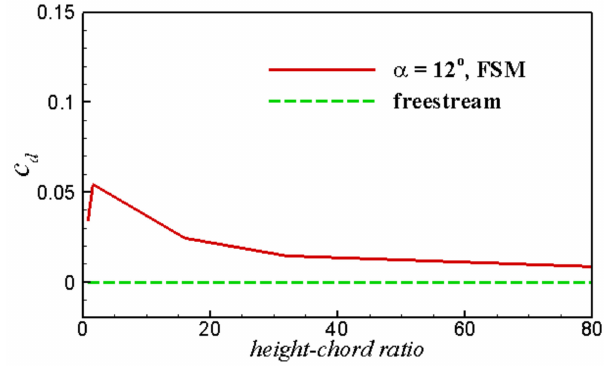
Figure 17. Variation of drag coefficient with height-chord ratio.